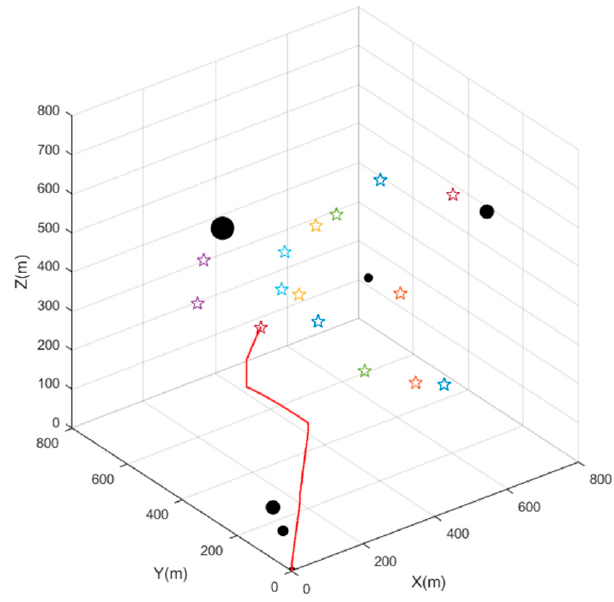
Figure 10. Search trajectory diagram (target (169.61, 334.14, 411.44)). After the AUV judges the suspected target point, if there is no suspected target within the sonar detection range, the perception map will be updated again according to the environmental information within the sonar detection range. The AUV makes search location decisions based on the search gain function, as shown in Figure 11, until the suspected target reappears in the sonar detection range.